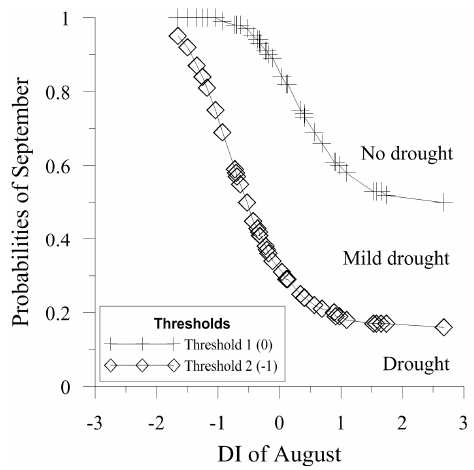
Figure 5. Probabilities of drought forecasts leaving the third year out in cross-validation using the BNFO model for the month of September given the DI of August corresponding respectively to the drought threshold values 0 and − 1.